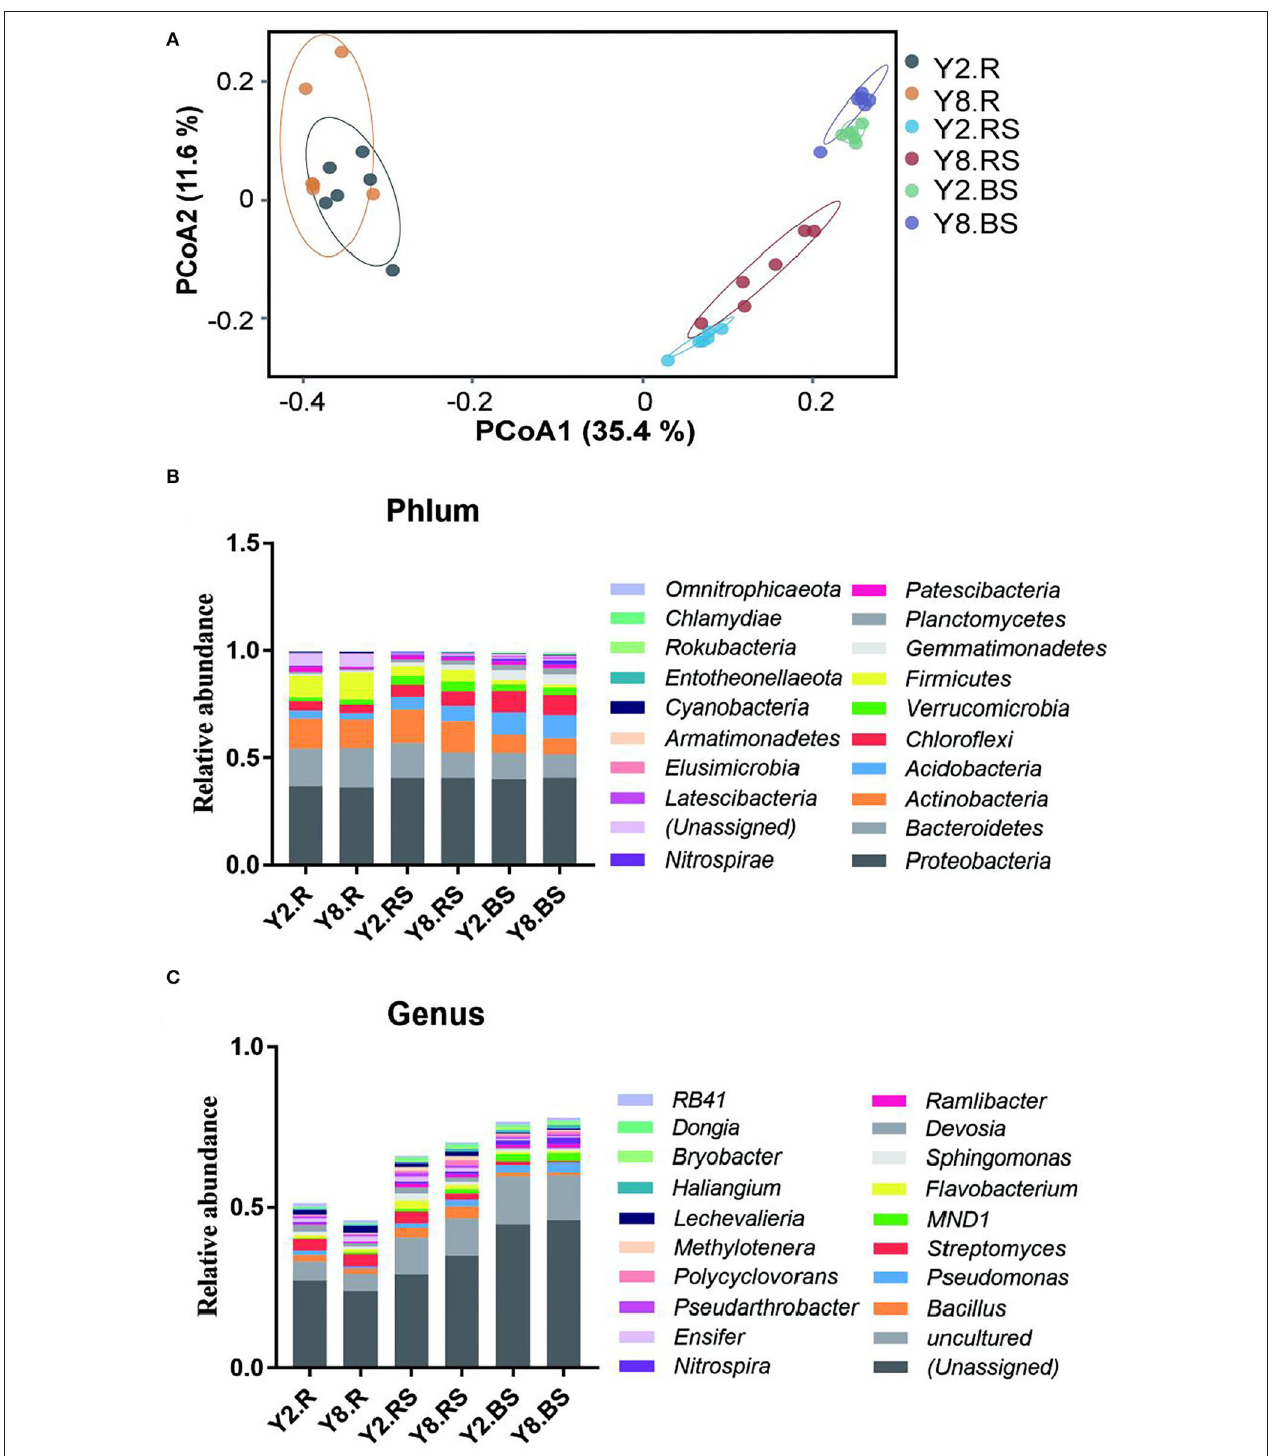
FIGURE 4 | The microbiome compositions and abundance distribution of bacterial taxa in all the groups. (A) Principal coordinate analysis (PCoA) of the microbial community among all the groups based on the Bray–Curtis distance. (B) The composition of the bacterial community at the phylum level. (C) The composition of the bacterial community at the genus level. Y2.R, root of 2 years of continuous cropping; Y8.R, root of 8 years of continuous cropping; Y2.RS, rhizosphere soil of 2 years of continuous cropping; Y8.RS, rhizosphere soil of 8 years of continuous cropping; Y2.BS, bulk soil of 2 years of continuous cropping; Y8.BS, bulk soil of 8 years of continuous